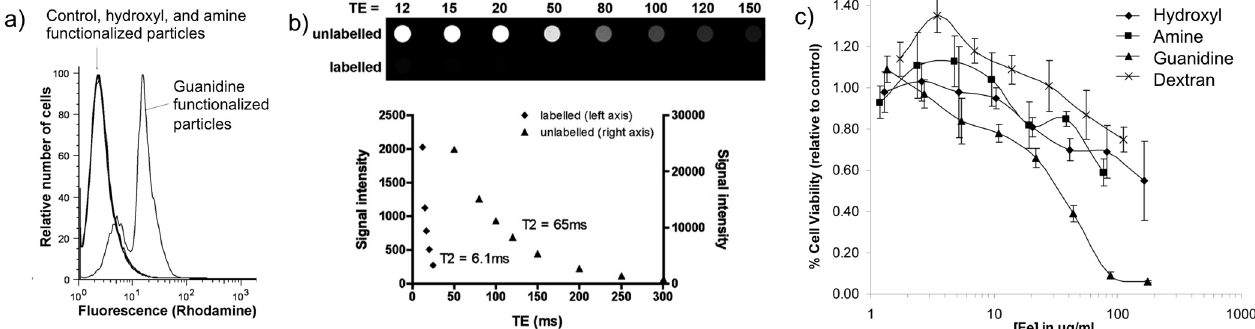
FIGURE 4 - a) Flow cytometry analyses of GL261 cells following incubation with dendron functionalized SPIO at a concentration of 25 µ g Fe/mL for 2 h; b) MRI signal intensity of unlabelled cells and cells labelled with dendritic guanidine functionalized SPIO, measured at 3T using a spin echo sequence with varying echo times (TE); c) Viability of GL261 cells after 24 h incubation with dendron functionalized SPIO, as measured by the MTT assay. Error bars represent standard deviations on 3 measurements (Martin et al. ,